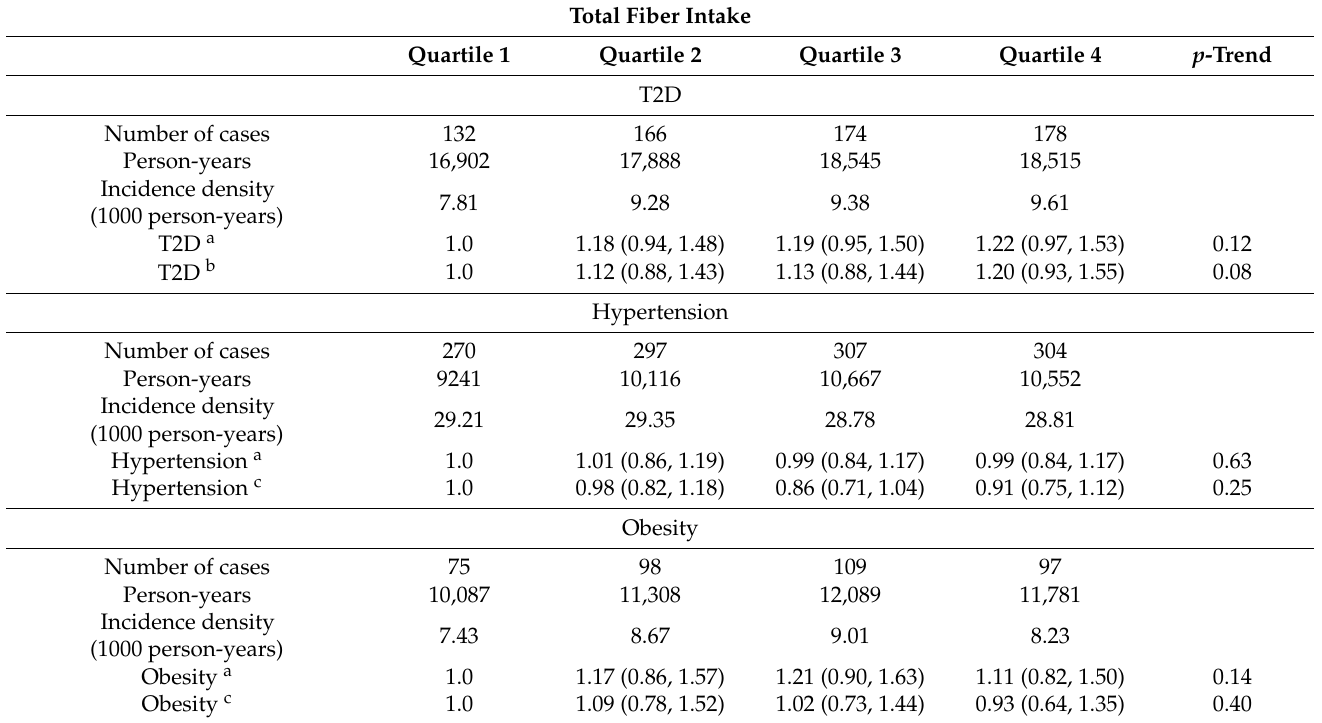
Table 2. Multi-variable adjusted HRs (95% CI) of T2D, hypertension, obesity, CVD, and all-cause mortality according to quartiles of total dietary